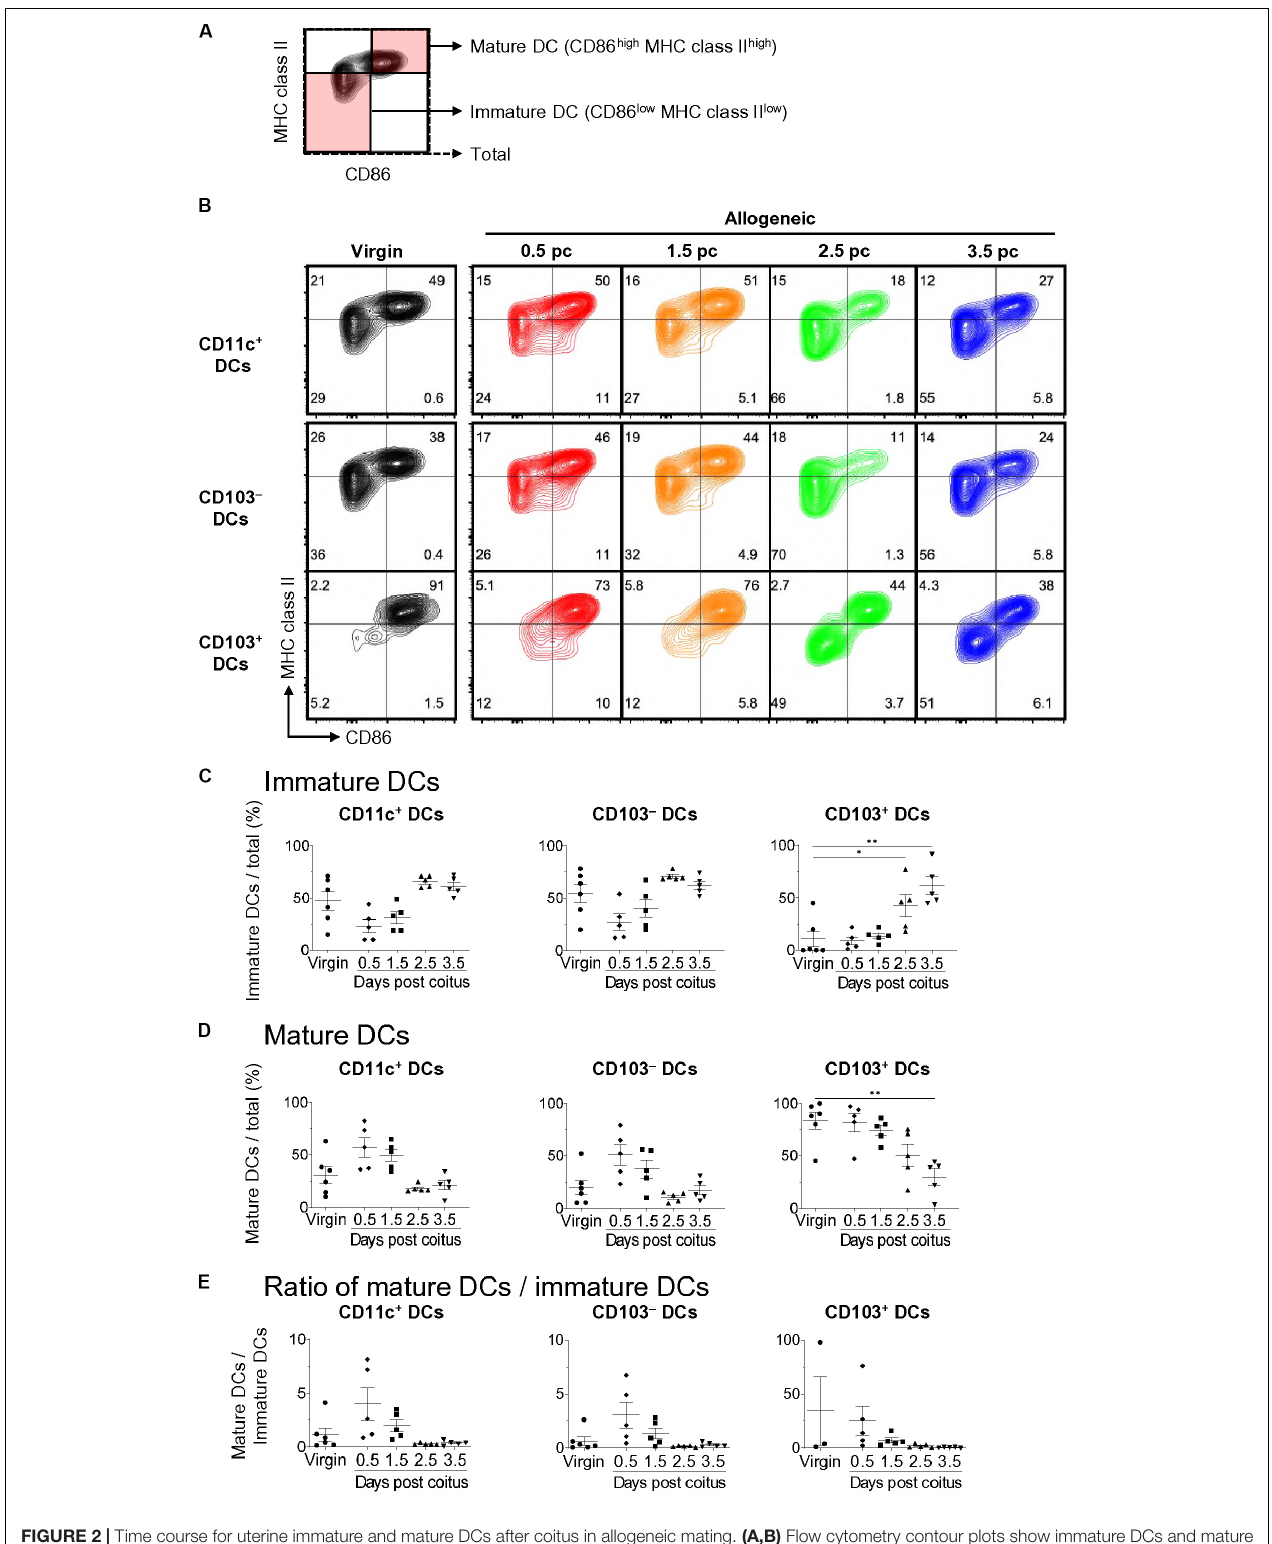
FIGURE 2 | Time course for uterine immature and mature DCs after coitus in allogeneic mating. (A,B) Flow cytometry contour plots show immature DCs and mature DCs based on the expression of CD86 and MHC class II (A) , and representative plots in proportion to those within each DC subset at each time point (B) . (C–E) Graphs show the proportion of immature DCs (C) and mature DCs (D) out of the total DCs, and ratio of mature DCs/immature DCs (E) in each DC subset at each time point. A minimum of five samples from each time point were analyzed. Data represent mean ± SEM (C–E) and are representative of three independent experiments. Statistical comparisons were performed using the Kruskal-Wallis test with Dunn’s multiple comparisons test ( ∗∗ P < 0.01, ∗ P < 0.05).